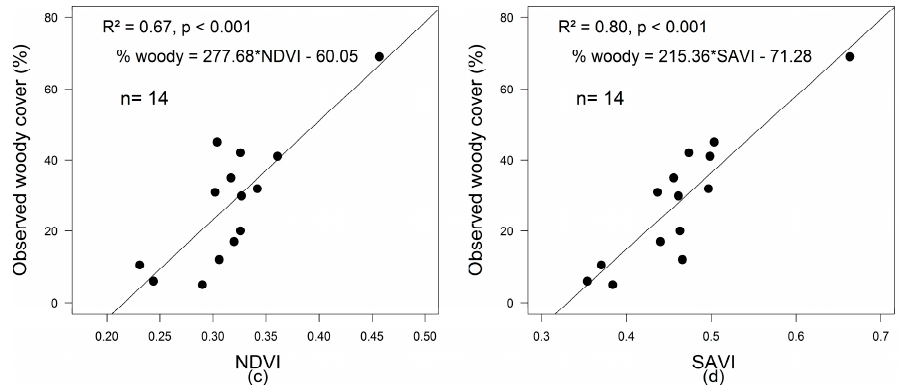
Figure 5. Calibration of NDVI and SAVI for woody estimate considering two methods for correcting